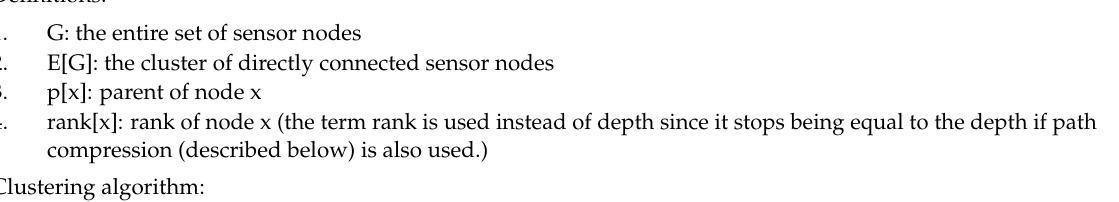
Algorithm 1 Operations of disjoint-set data